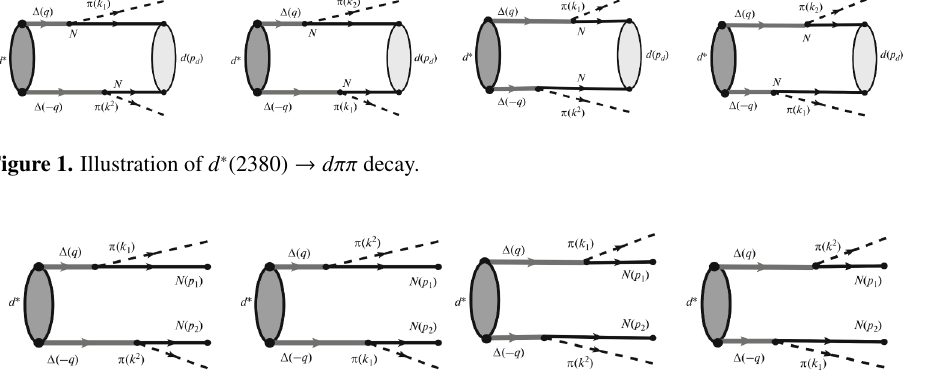
Figure 2. Illustration of d (cid:3) (2380) ! NN (cid:25)(cid:25) decay.